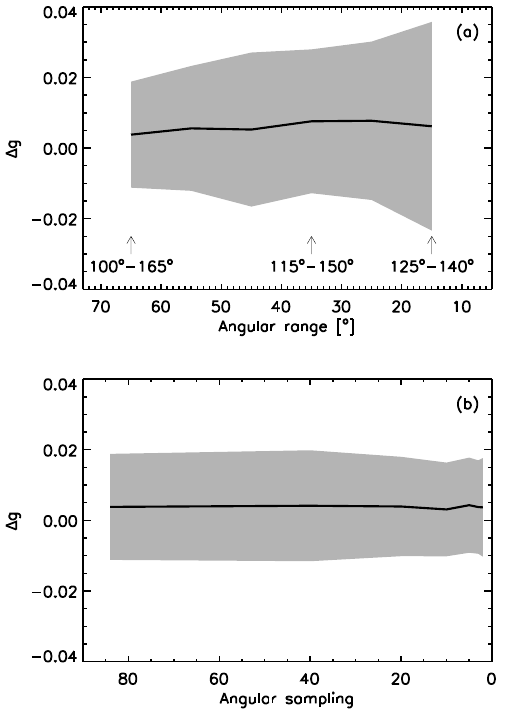
Fig. 11. As Fig. 10 but showing dependence of results on angular range (a) and number of scattering angles sampled (b) . In (a) , max- imum and minimum values of the included scattering angles for three example angular ranges are indicated. See text for